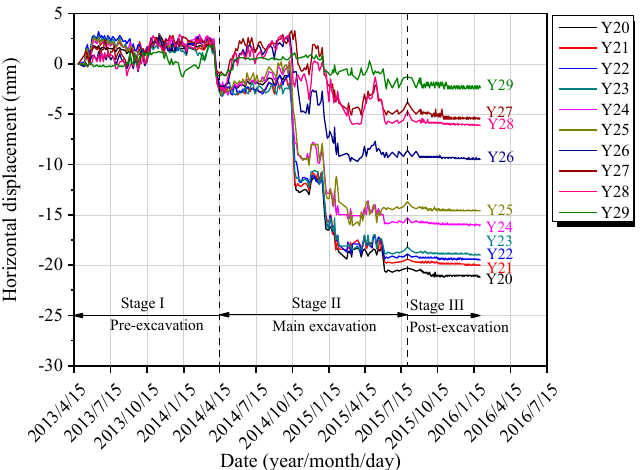
Figure 18. Horizontal displacement evolution curves of the up-track tunnel.